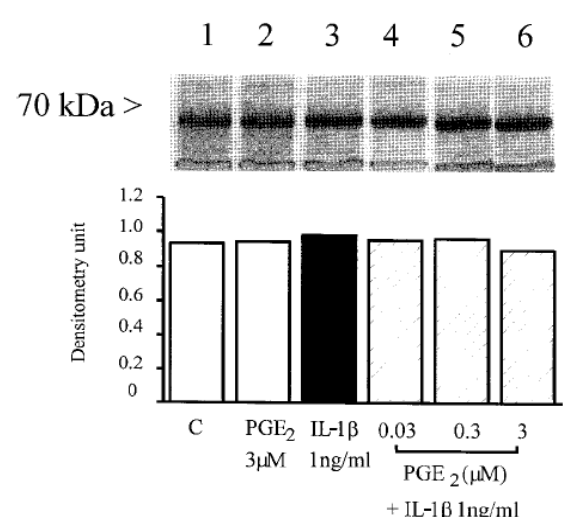
FIG. 4. The effects of PGE 2 on COX-1 protein expressed in IL- 1 b (1ng/ml) treated HUVEC. COX-1 protein was detected by Western blots using polyclonal antibodies to COX-2 in cell extracts of HUVEC treated with no addition (lane 1), PGE 2 (3 m M) alone (lane 2), IL-1 b (1ng/ml) alone (lane 3) or IL-1 b (1ng/ml) plus PGE 2 (0.03, 0.3 or 3 m M; lanes 4–6) for 24h. Equal amounts of protein (20 m g/lane) were loaded in each lane. Similar results were obtained with cell extracts from three separate batches of cells. The significant differences between each band were compared by scanner densito- metry using image 1D program (densitometry unit).